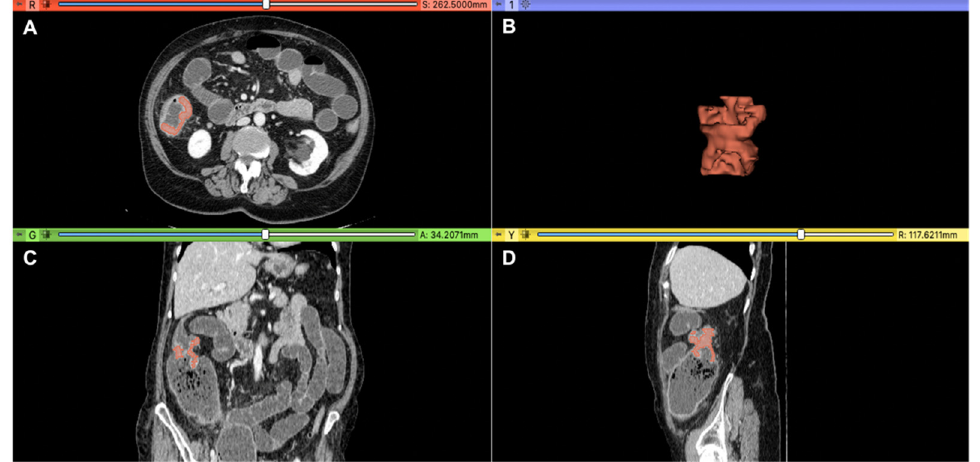
Figure 2. Colon cancer 3D segmentation in the portal phase performed by using Slicer software (version 4.10.2, https://download.slicer.org, accessed on 17 March 2021). Panel ( A ) displays the axial, ( B ) 3D volumetric segmentation, ( C ) coronal, and ( D ) sagittal plans .